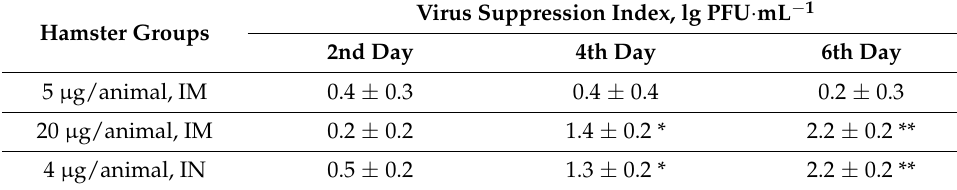
Table 3. Virus Suppression Index for vaccinated